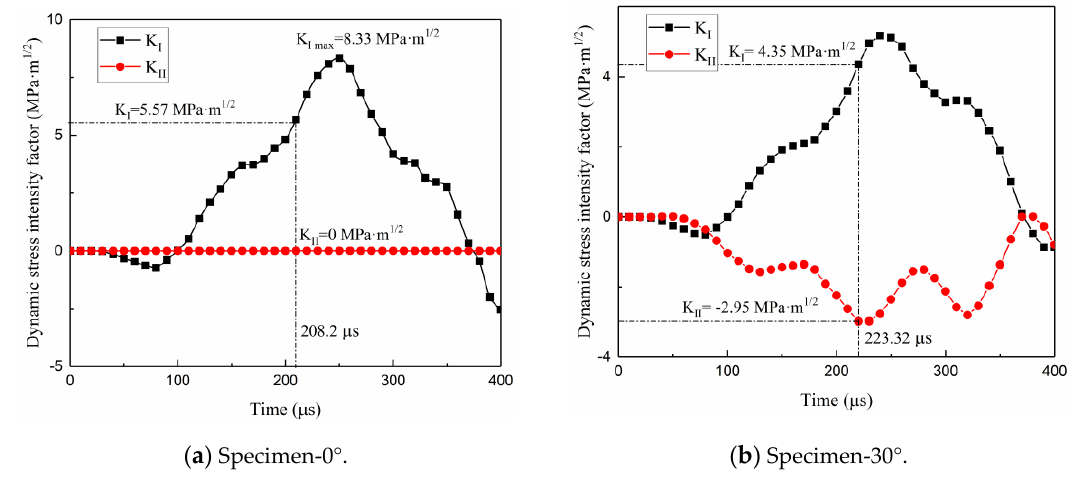
Figure 10. Dynamic stress intensity factor curves and determination of DISIF. ( a ) Historical DSIF curve of specimen-0°. ( b ) Historical DSIF curve of specimen-30 ° .